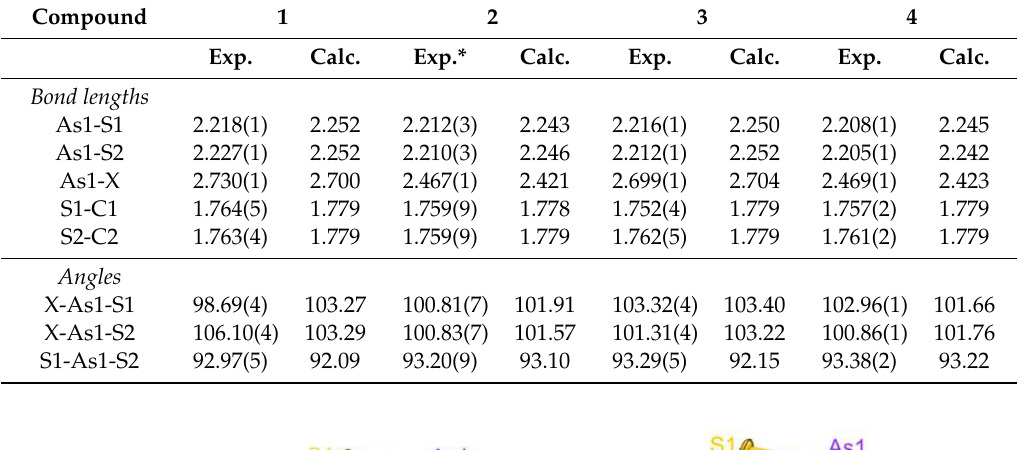
Table 1. Selected bond lengths (Å ) and angles (°) of complexes 1 − 4 obtained from experiment and DFT calculations (B3LYP/6-31+G(d,p);LANL2DZ) (X = I1 ( 1 and 3 ) and Br1 ( 2 and 4 )). * In the case of 2 the experimental data are given as mean values from 13 molecules.